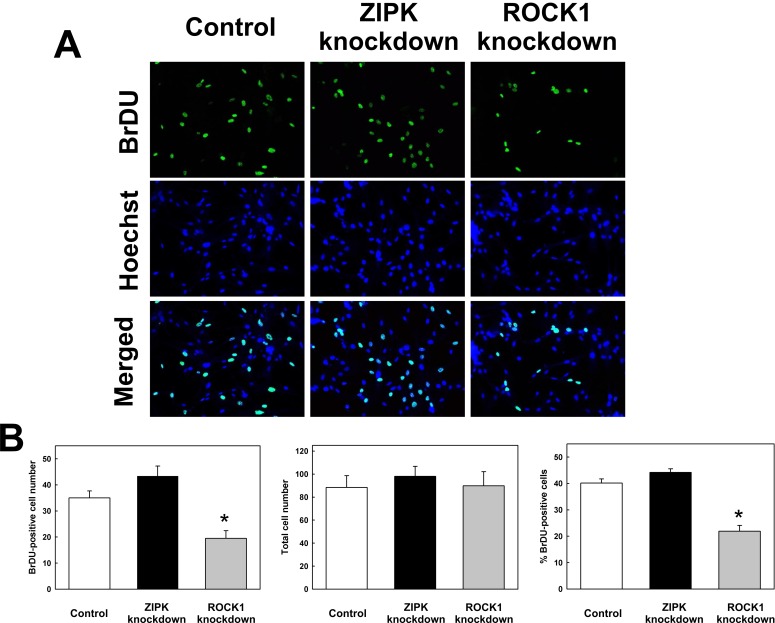
Effects of ROCK1 and ZIPK knockdown on cell proliferation.BrDU incorporation was observed by anti-BrDU staining in UASMC 48 h following transfection with siRNA to ZIPK or ROCK1 or with negative control siRNA. (A) Representative fields of cells are shown stained with anti-BrDU (top panels) or Hoechst nuclear stain (middle panels) with merged images shown in the bottom panels. (B) Quantitative data showing the numbers of BrDU-positive cells (left panel), total numbers of cells (middle panel) and % BrDU-positive cells (right panel). Fields were chosen to contain approximately the same number of cells (as shown in the middle panel) although, as shown by the MTT assay (Fig. 5), ROCK1 knockdown reduced overall cell viability. Values represent means ± SEM (n = 4 independent experiments, in each of which 3 fields of cells were counted for control, ZIPK knockdown and ROCK1 knockdown). *significantly different from control (p < 0.01).